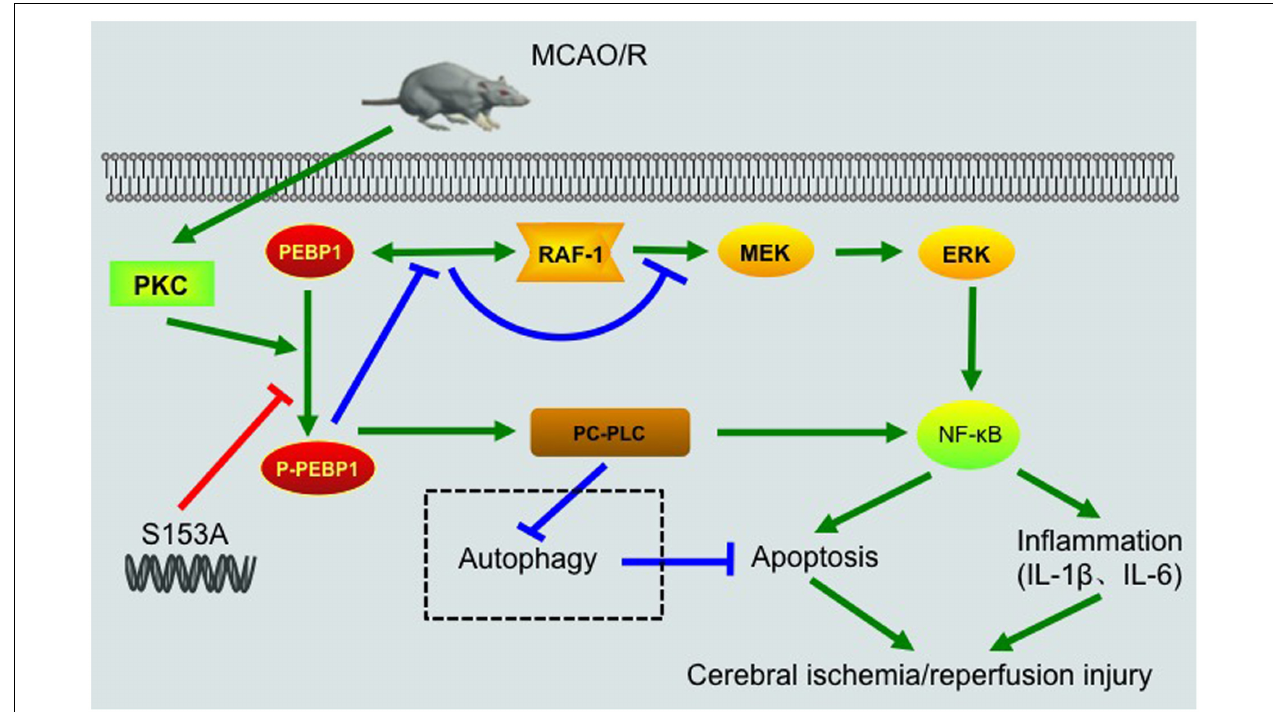
FIGURE 8 | Schematic representations of potential mechanisms of PEBP1 in enhancing inflammatory response and neuron apoptosis after I/R injury. Under normal condition, PEBP1 binds to Raf-1 and inhibits the Raf-1/MEK/ERK/NF- κ B signaling pathway indirectly. Following MCAO/R, I/R stimulus induces an increase in the protein of PEBP1 and activates PKC, which in turn promotes the phosphorylation of PEBP1. The phosphorylation of PEBP1 inhibits the interaction between PEBP1 and Raf-1, and relieves the Raf-1/MEK/ERK/NF- κ B signaling pathway. Subsequently, the released p-PEBP1 from Raf-1 binds to another binding partner PC-PLC. The phosphorylated PEBP1 promotes PC-PLC activation, which further enhances NF- κ B signaling pathway and regulates autophagy negatively. Finally, excessive NF- κ B signaling and abnormal autophagy enhance the inflammatory response and neuron apoptosis, and aggravates cerebral I/R injury. The switch of PEBP1 from Raf-1 to PC-PLC was inhibited by mutation the Ser153 of PEBP1 to